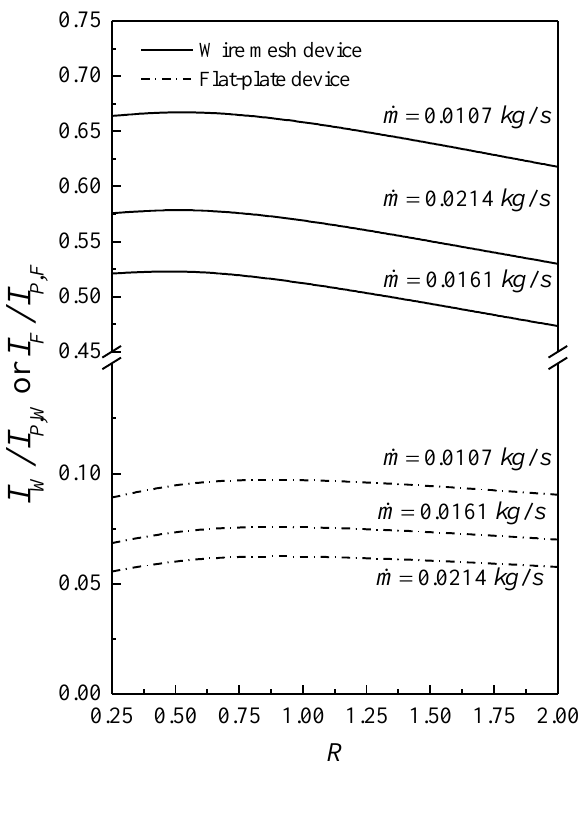
Figure 7. The values of I W / I P,W and I F / I P,F vs. recycle ratio with air mass flow rate as a